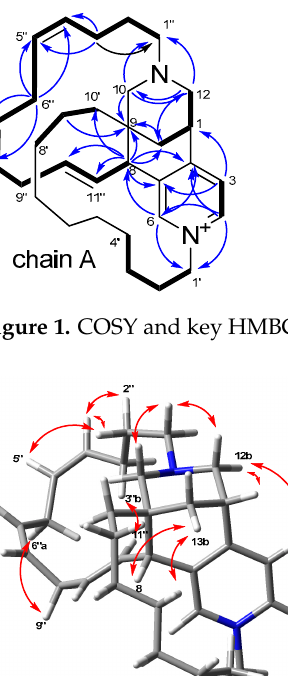
Figure 1. COSY and key HMBC correlations in 1 .